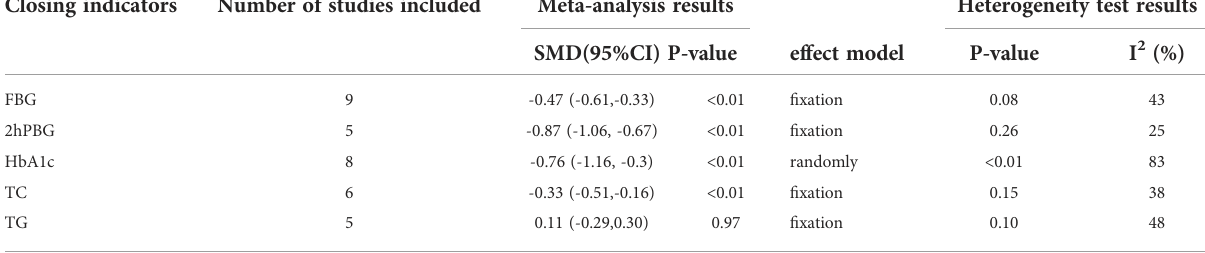
TABLE 5 Meta-analysis results of blood glucose and blood lipid. Closing